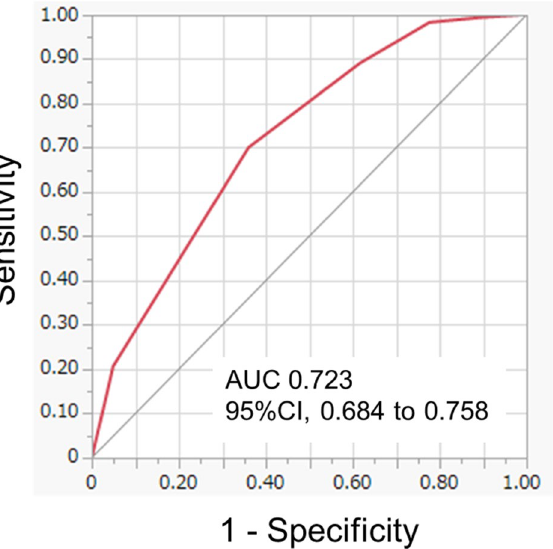
Figure 3. The area under the receiver operating characteristic curve of the J-ERATO score to predict the presence of DIC on day 1. The J-ERATO score cut-off of 5 points provided optimal sensitivity and specificity to predict the presence of DIC on day 1 (AUC [95%CI], 0.723 [0.684–0.758]; sensitivity, 70.1% [63.1–76.3]; specificity, 64.0% [60.2–67.6]; PPV, 35.8% [31.1–40.9]; NPV, 88.2% [84.9–90.8]; positive likelihood ratio, 1.9 [1.7–2.2]; negative likelihood ratio,0.5 [0.4–0.6]). AUC, the area under the receiver operating characteristic curve; CI, confidence interval; DIC, disseminated intravascular coagulation; PPV, positive predictive values; NPV, negative predictive values.